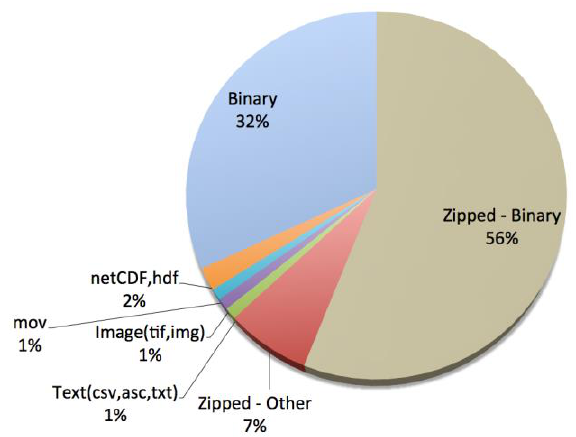
Figure 2. Data volume distribution of data sets in the ORNL DAAC data holdings (n = 1126).